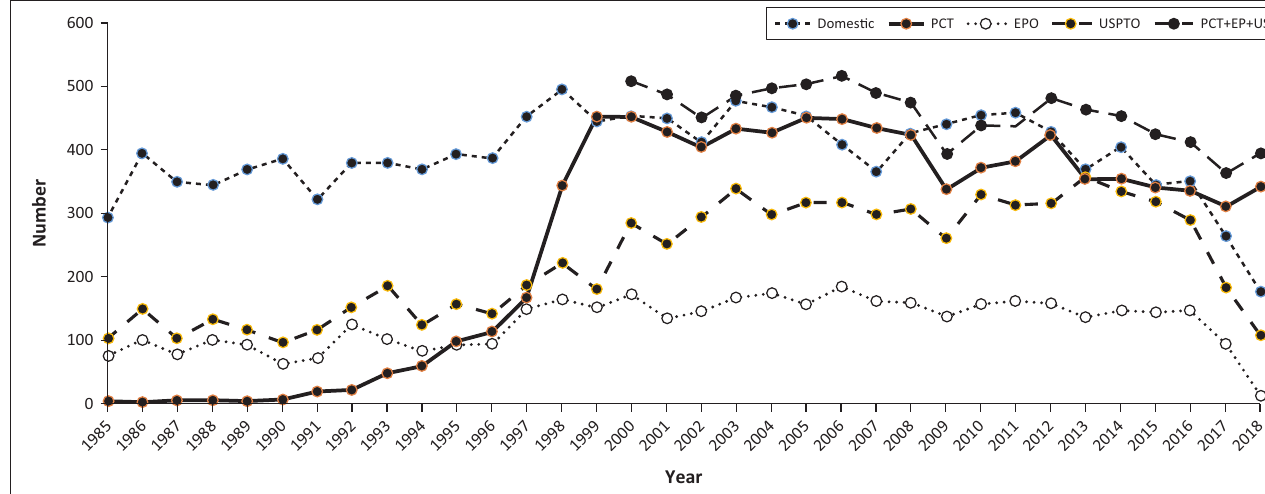
FIGURE 1 : Patent applications of South Africans in different patent